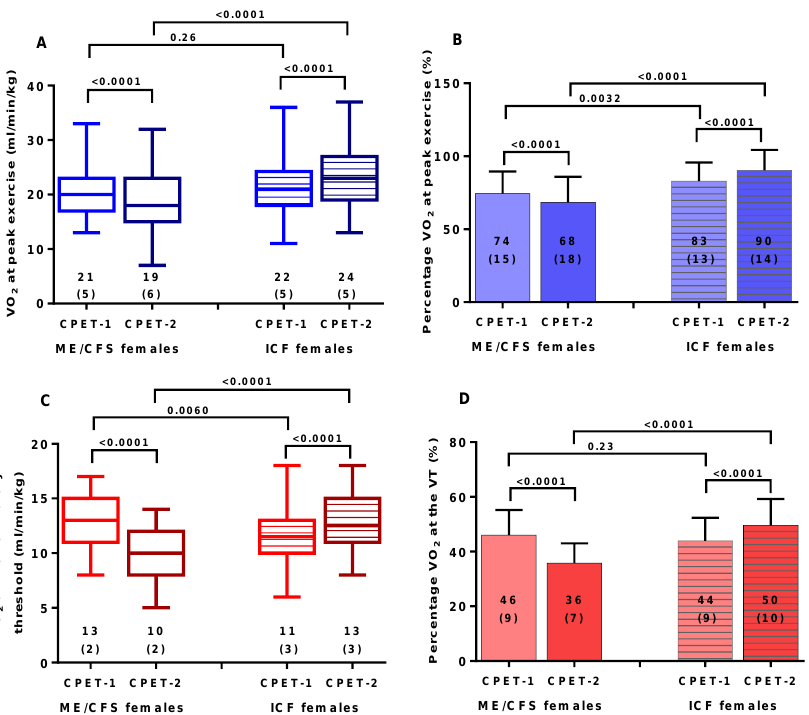
Figure 1. Peak exercise values and values at the ventilatory threshold for CPET-1 and CPET-2 (panel ( A ): peak oxygen consumption, panel ( B ): percent predicted peak oxygen consumption, panel ( C ): oxygen consumption at the ventilatory threshold, and panel ( D ): percent predicted oxygen consumption at the ventilatory threshold) for female ME/CFS and female ICF patients. CPET: cardiopulmonary exercise test; VT: ventilatory threshold; VO 2 : volume of oxygen consumption; ME/CFS: myalgic encephalomyelitis/chronic fatigue syndrome; ICF: idiopathic chronic fatigue.